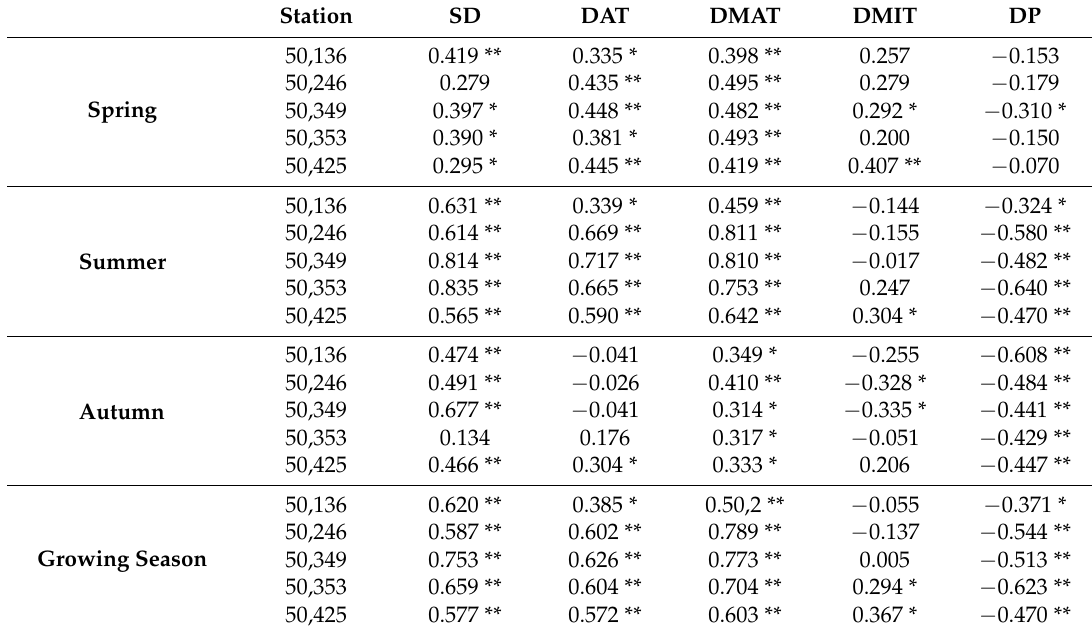
Table 1. Correlation coefficients of the AG in three seasons and the growing season versus meteorological factors obtained from five different meteorological stations over the GKM from 1982 to